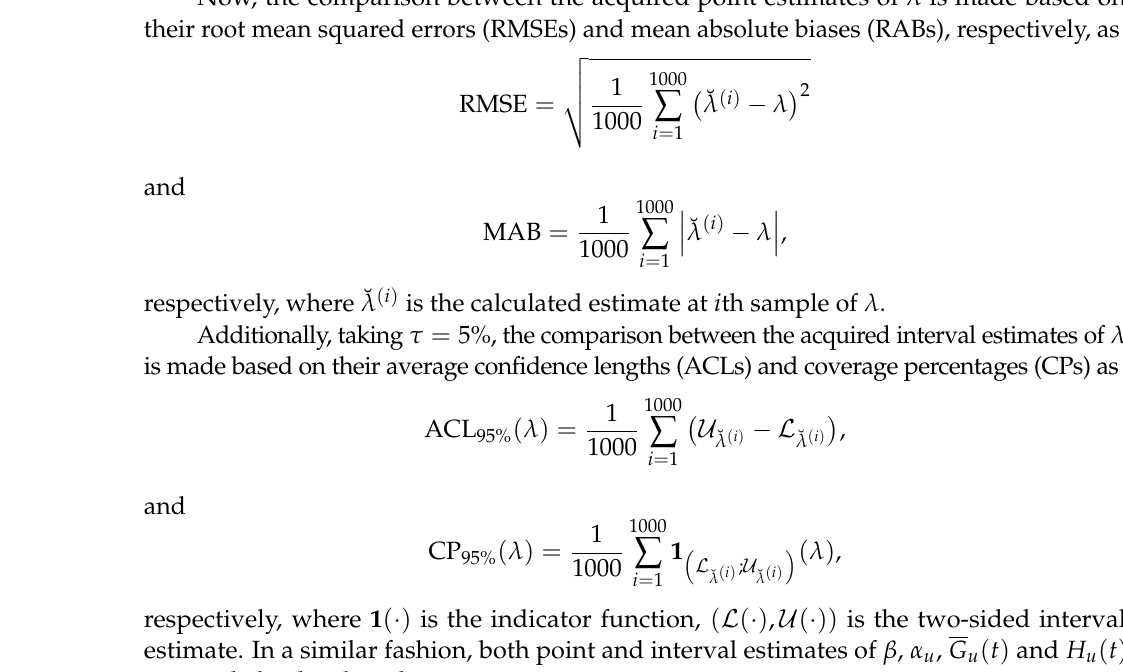
and respectively, where 1 ( · ) is the indicator function, ( L ( · ) , U ( · )) is the two-sided interval estimate. In a similar fashion, both point and interval estimates of β , α u , G u ( t ) and H u ( t ) can easily be